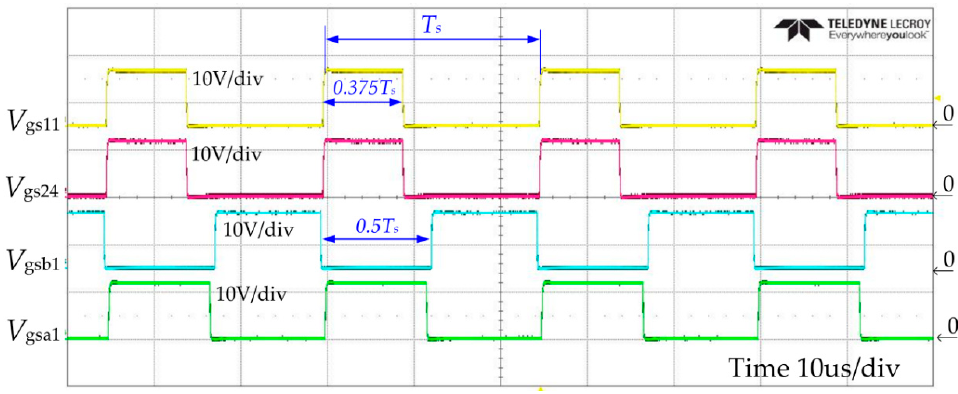
Figure 12. PWM Signals of switches S 11 , S 24 , S a1 and S a2.